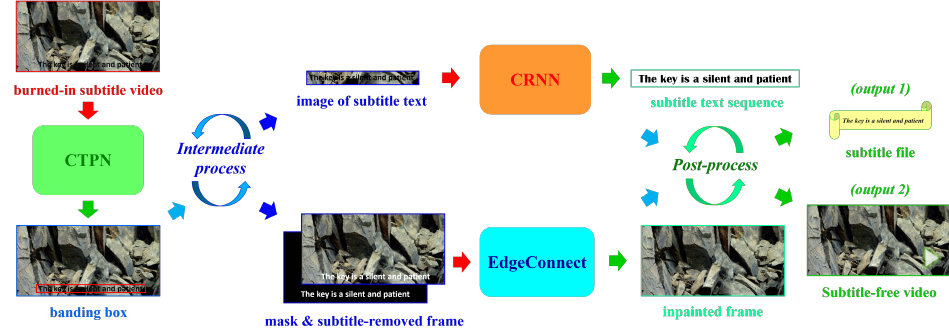
Figure 2. The processing flow of the entire deep-learning-based pipeline for burned-in subtitle video reconstruction, mainly consisting of two processes: an intermediate-process (for network coupling) and a post-process (for output